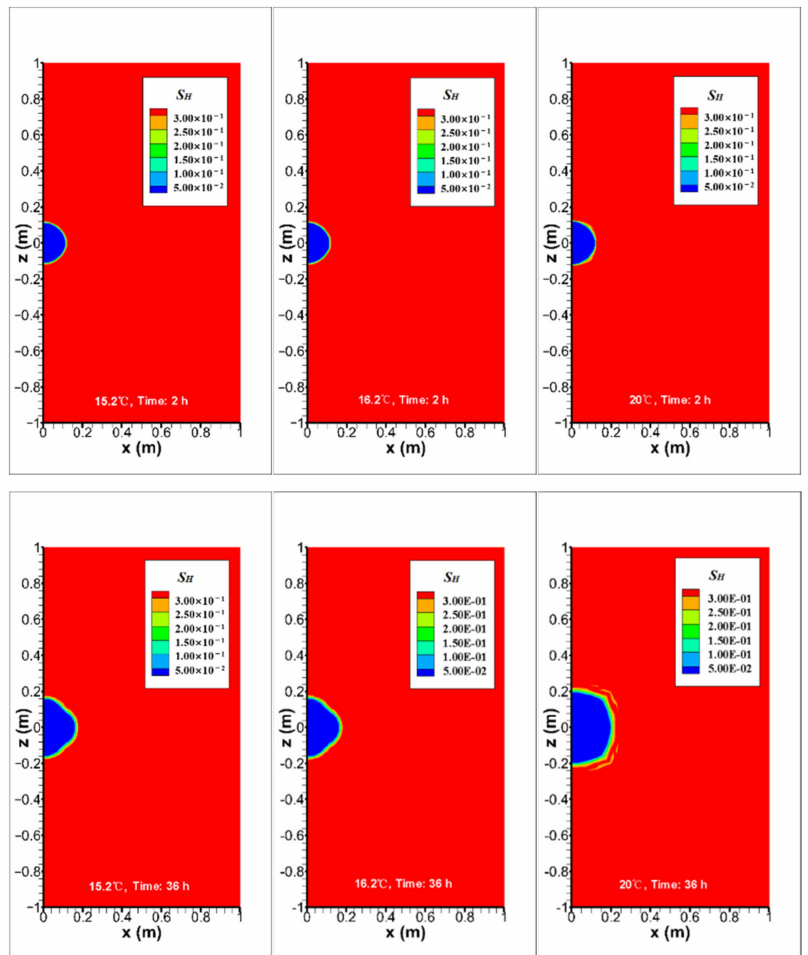
Figure 7. NGH saturation distribution evolution of the near-wellbore reservoir with different tem- peratures of drilling